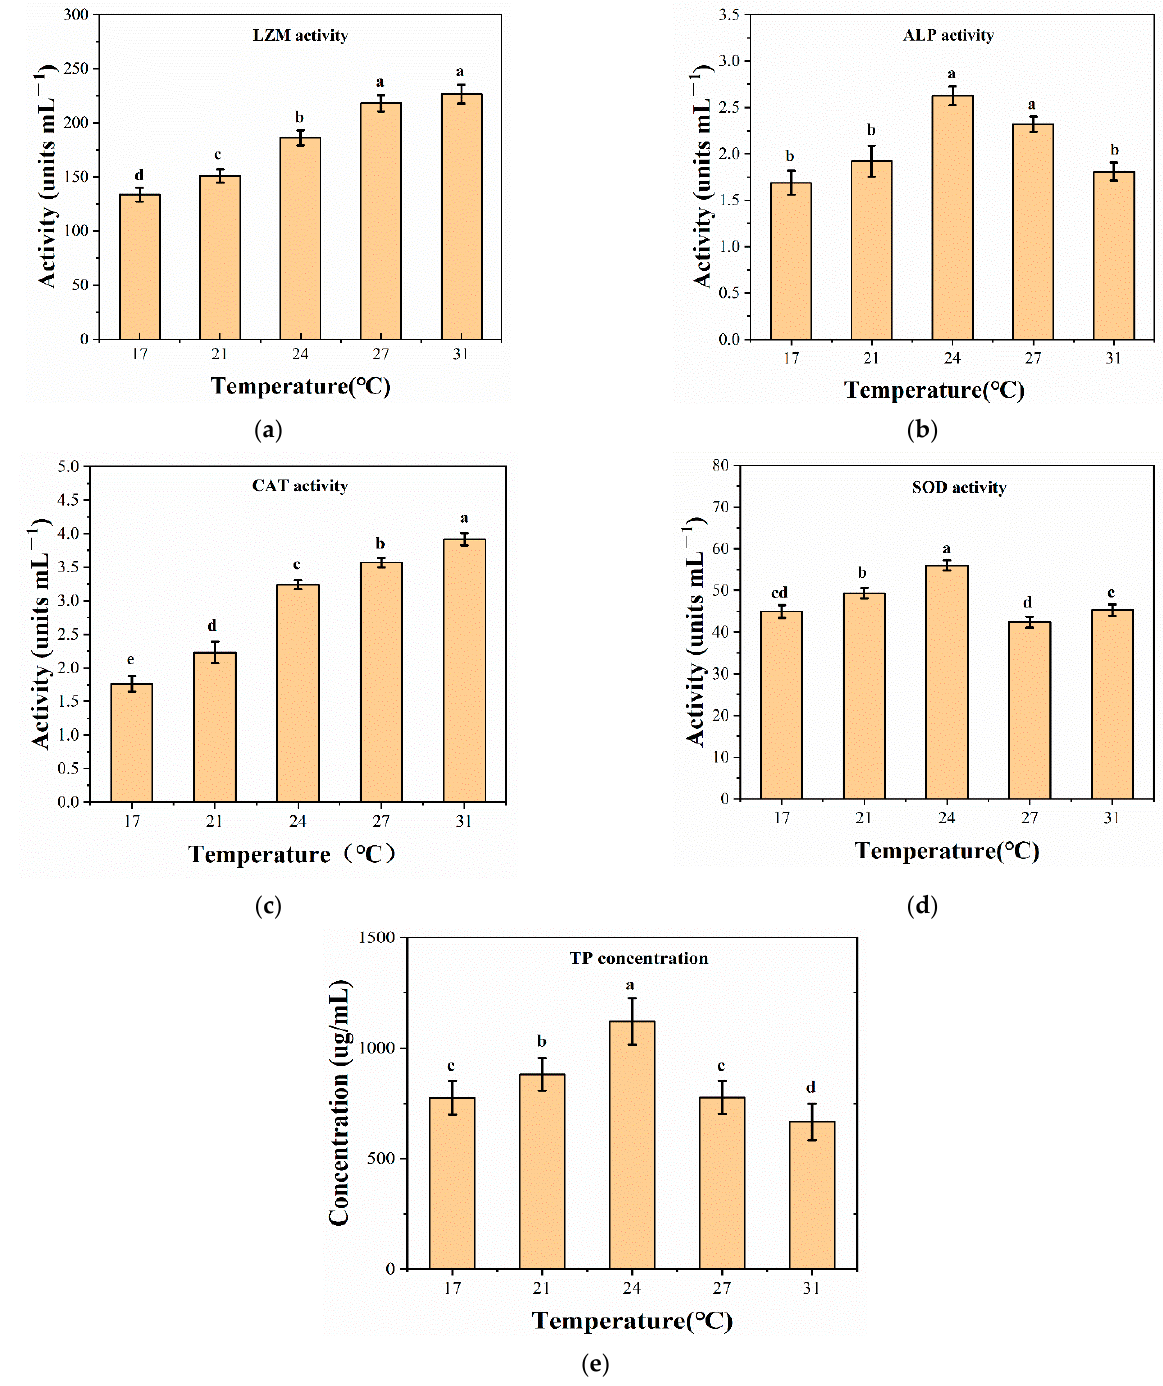
Figure 3. Determination of enzyme activities and total protein concentration in epidermal mucus treated at different temperatures: ( a ) LZM, ( b ) ALP, ( c ) CAT, ( d ) SOD, and ( e ) TP. Values are represented as mean ± SD of pooled data from triplicates per treatment ( n = 3). Means in the same row with different letters are significantly different ( p < 0.05).